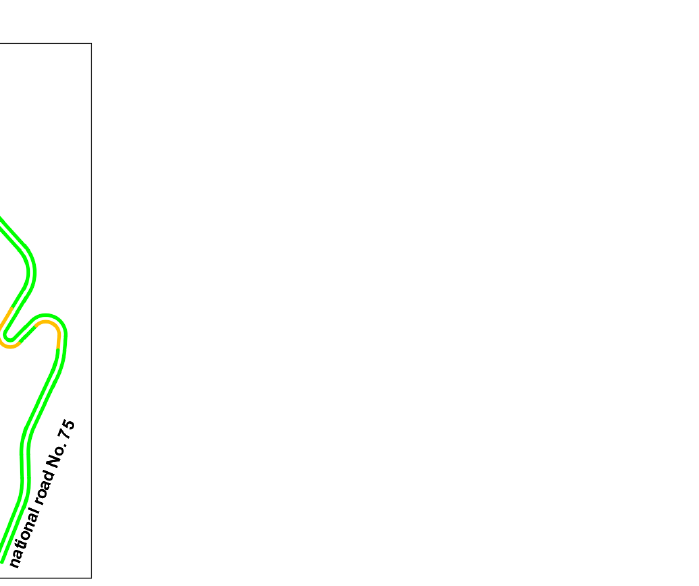
Figure 7. Change in the travel speed caused by a road’s geometrical features and traffic features. The left panel shows the situation at 2:30 pm in conditions of a higher traffic volume, and the right one at 8:30 pm when traffic volume is low.